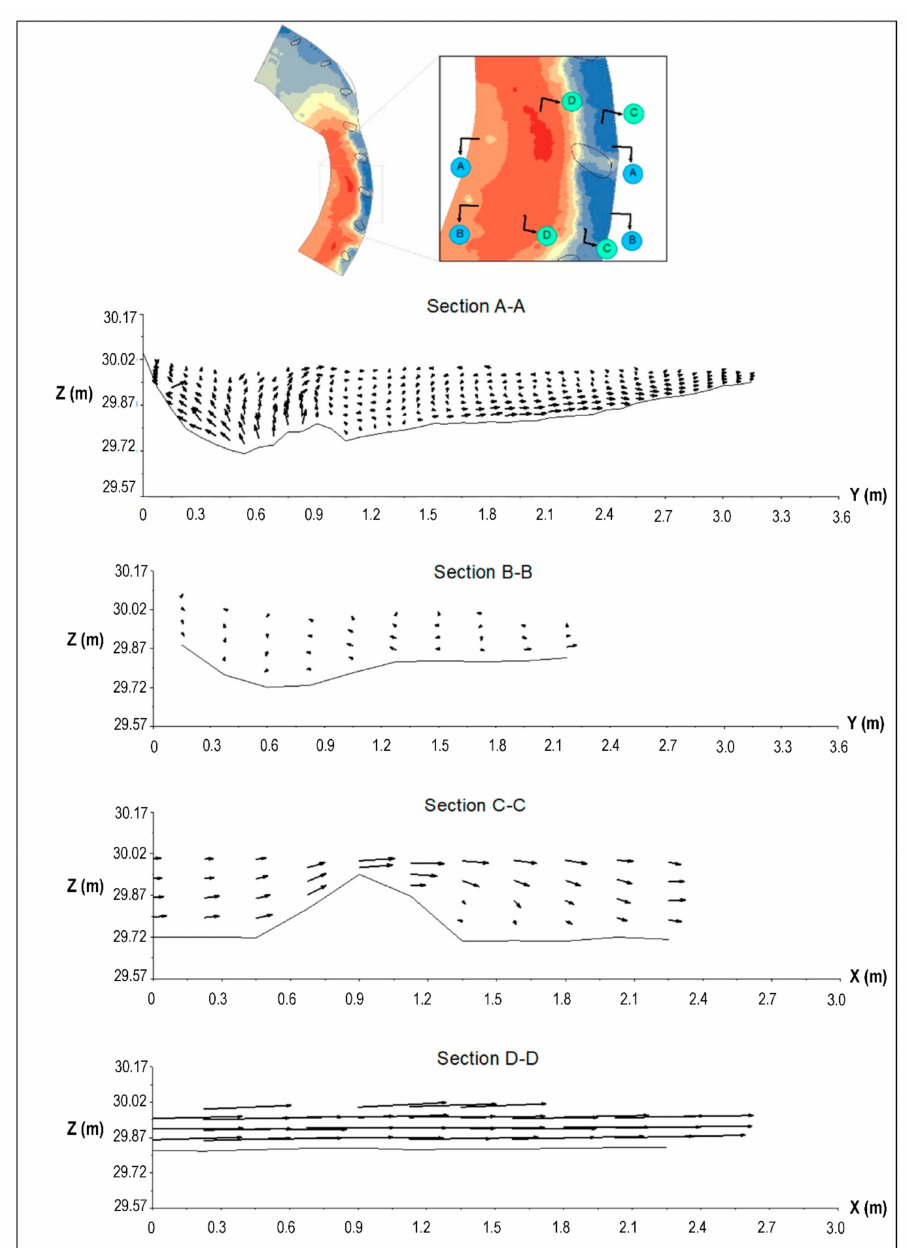
Figure 25. Measured velocity vectors for bendway weir configuration